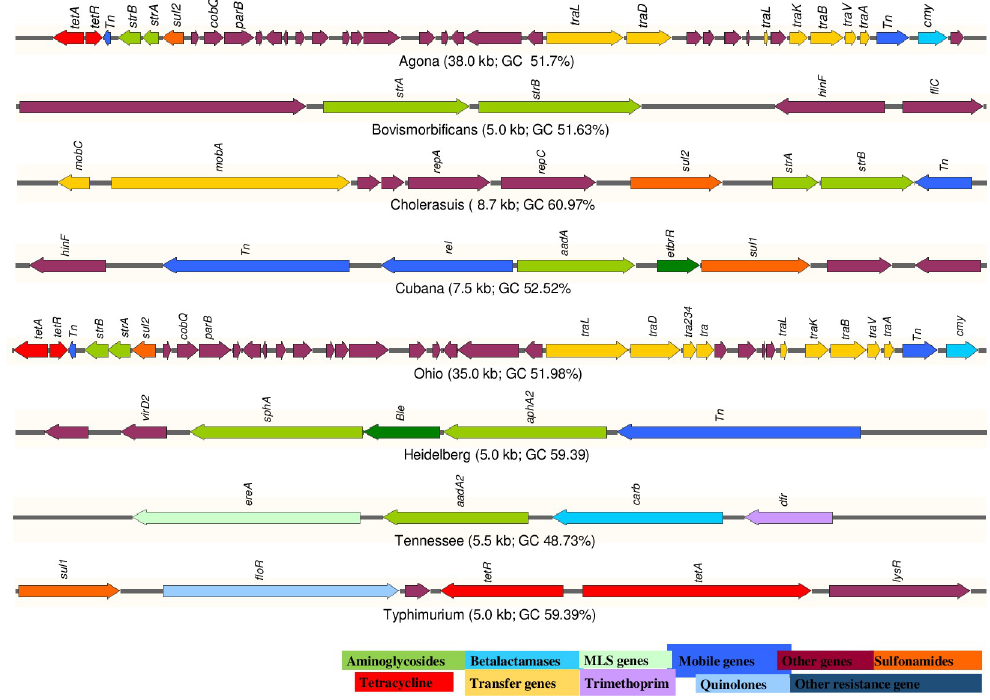
Fig 1. Antibiotic resistance gene clusters in different Salmonella serotypes. Bleomycin and EtBr resistance gene (Green) flanked by antibiotic resistance genes marked in green. The arrow shows orientation of the genes and genes are color coded to define different classes of antibiotic resistance, mobile and other genes